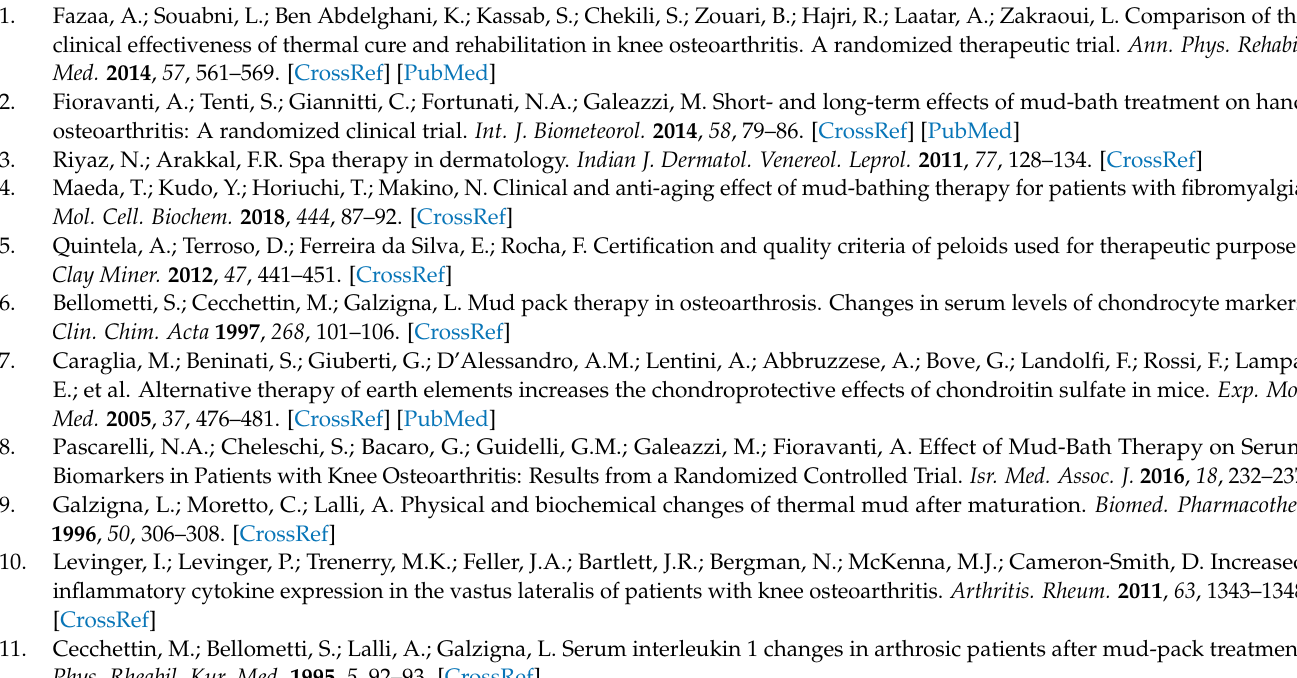
Table S1: WOMAC and SF-36